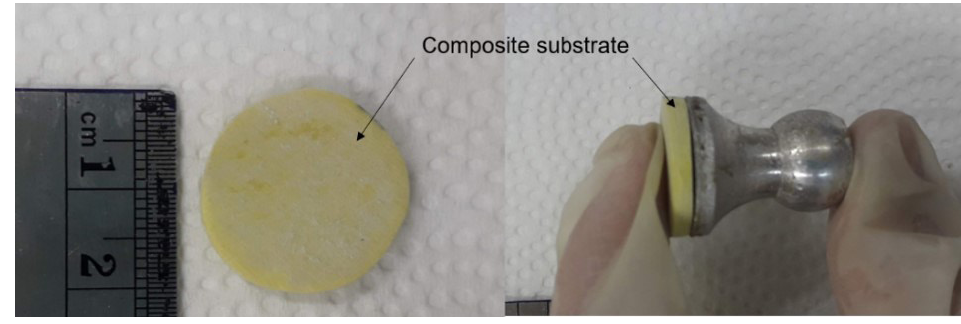
Figure 1. Composite samples for pull off tests.